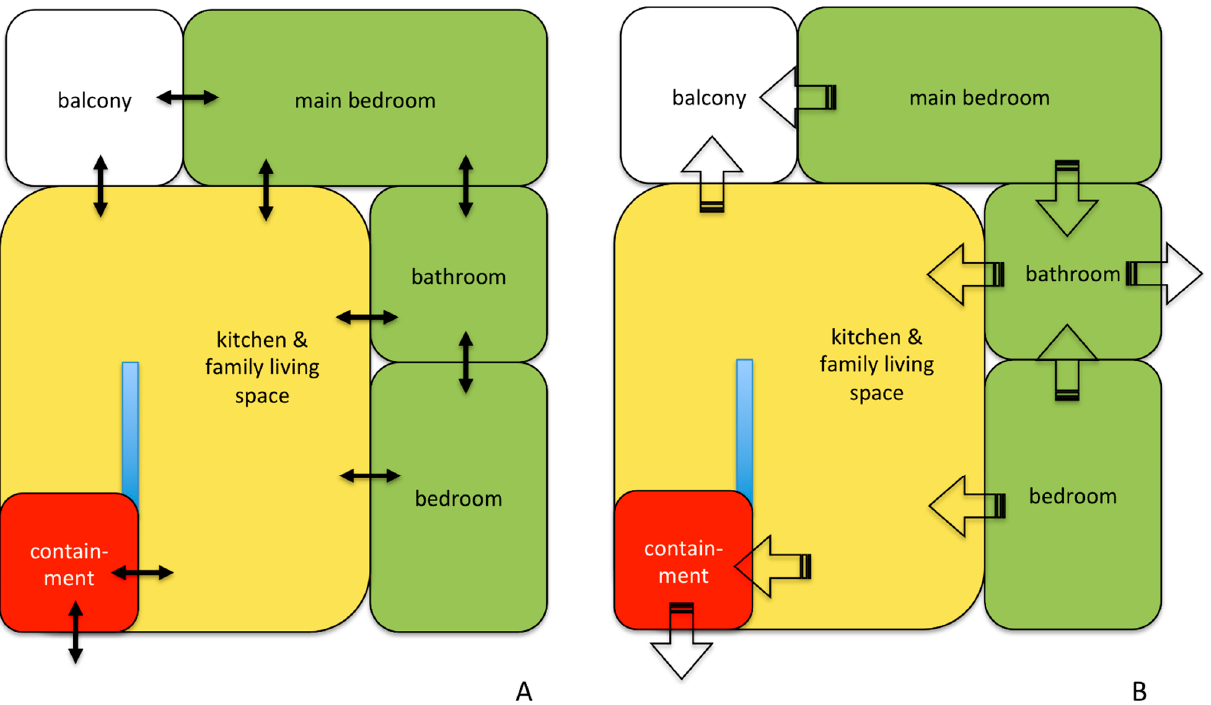
Figure 2. Conceptualizing internal zoning of domestic of two-bedroom dwelling spaces to com- partmentalize exposure to infectious agents: ( A ) internal connectivity; ( B ) airflow directions.